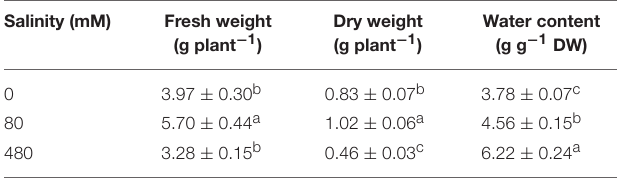
TABLE 3 | Effects of salinity stress on the growth of K. sieversiana . Salinity